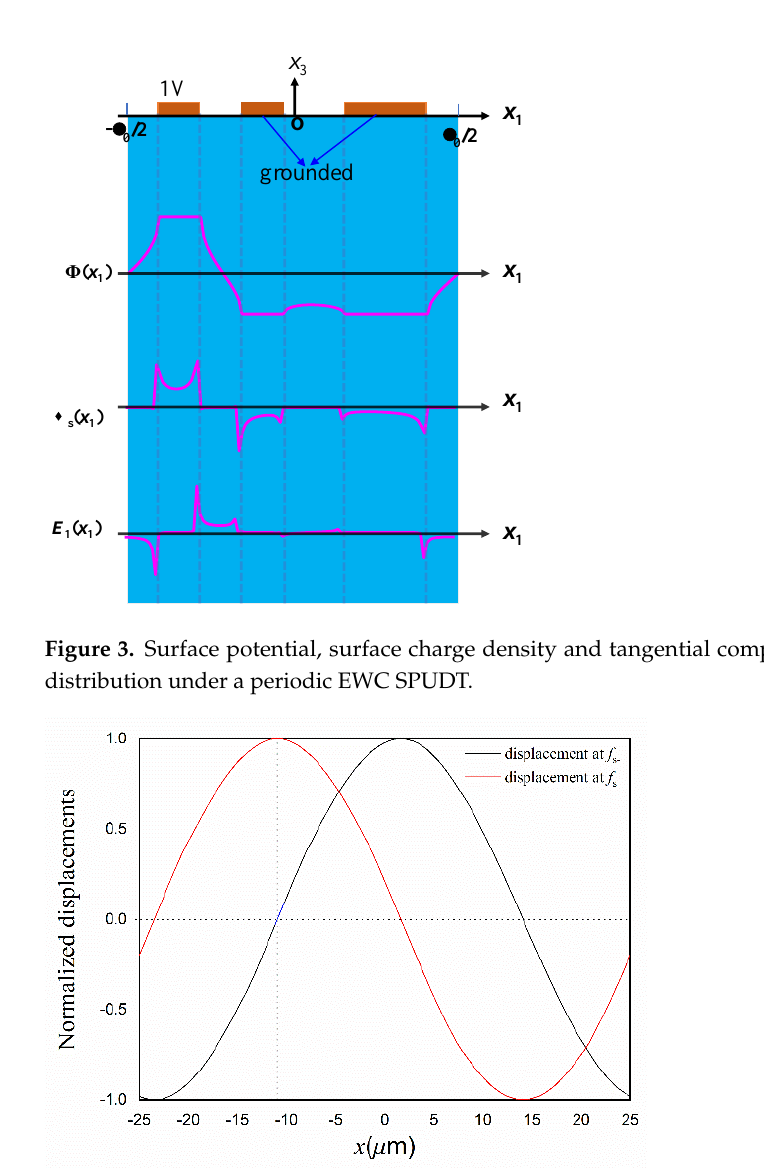
Figure 4. Normalized displacement distributions at the lower and upper edge frequencies.